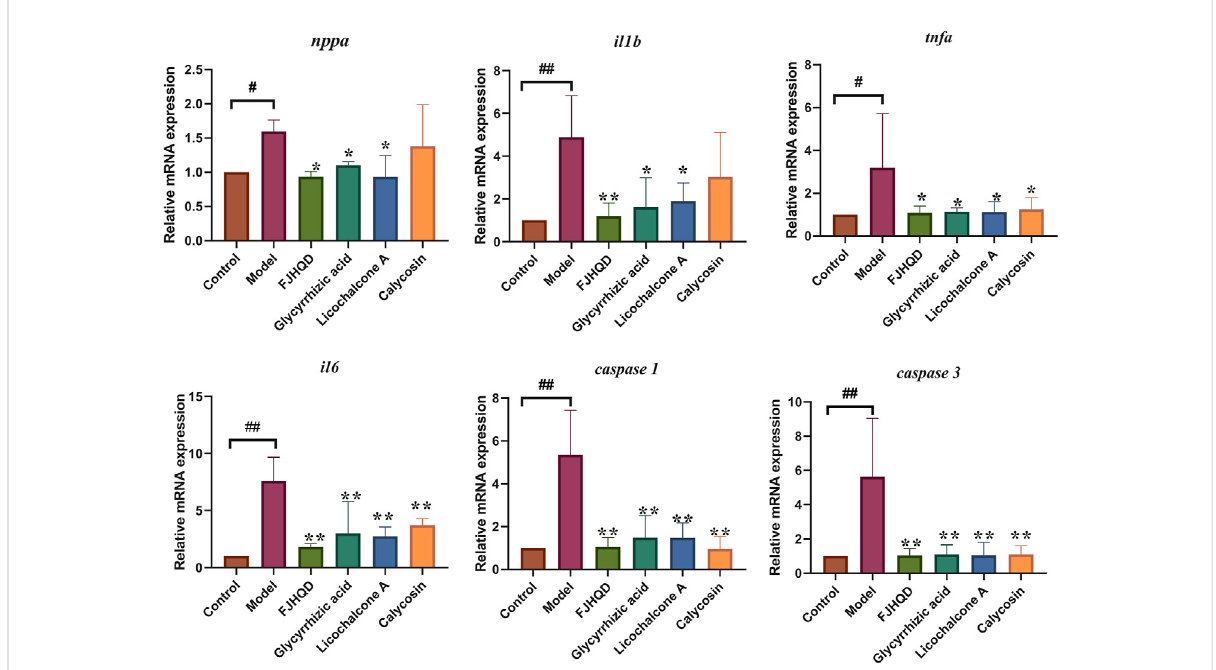
FIGURE 8 The mRNA relative expression of nppa, tnfa, il1b, il6, caspase 1 and caspase 3 . N = 3. # p < 0.05 vs . Control, ## p < 0.01 vs . Control, * p < 0.05 vs . Model, ** p < 0.01 vs .